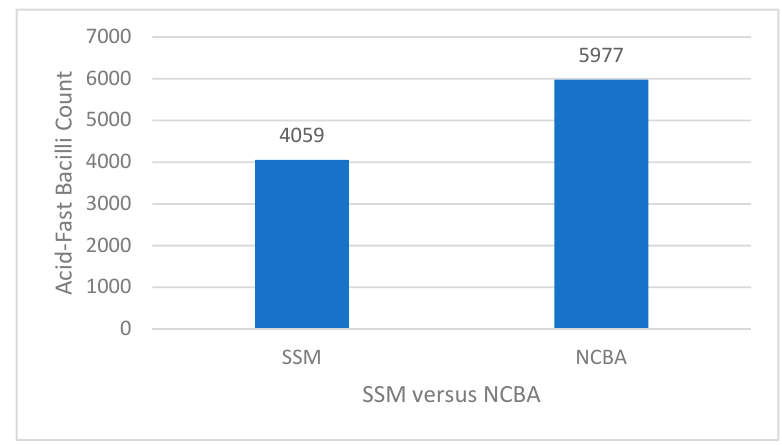
Figure 2. Results of the optimized parameters using 0.4% NaOH/4% NALC and 10 mg/mL glycan-functionalized magnetic nanoparticles (GMNP), with NCBA increasing AFB count by 47% compared to SSM.